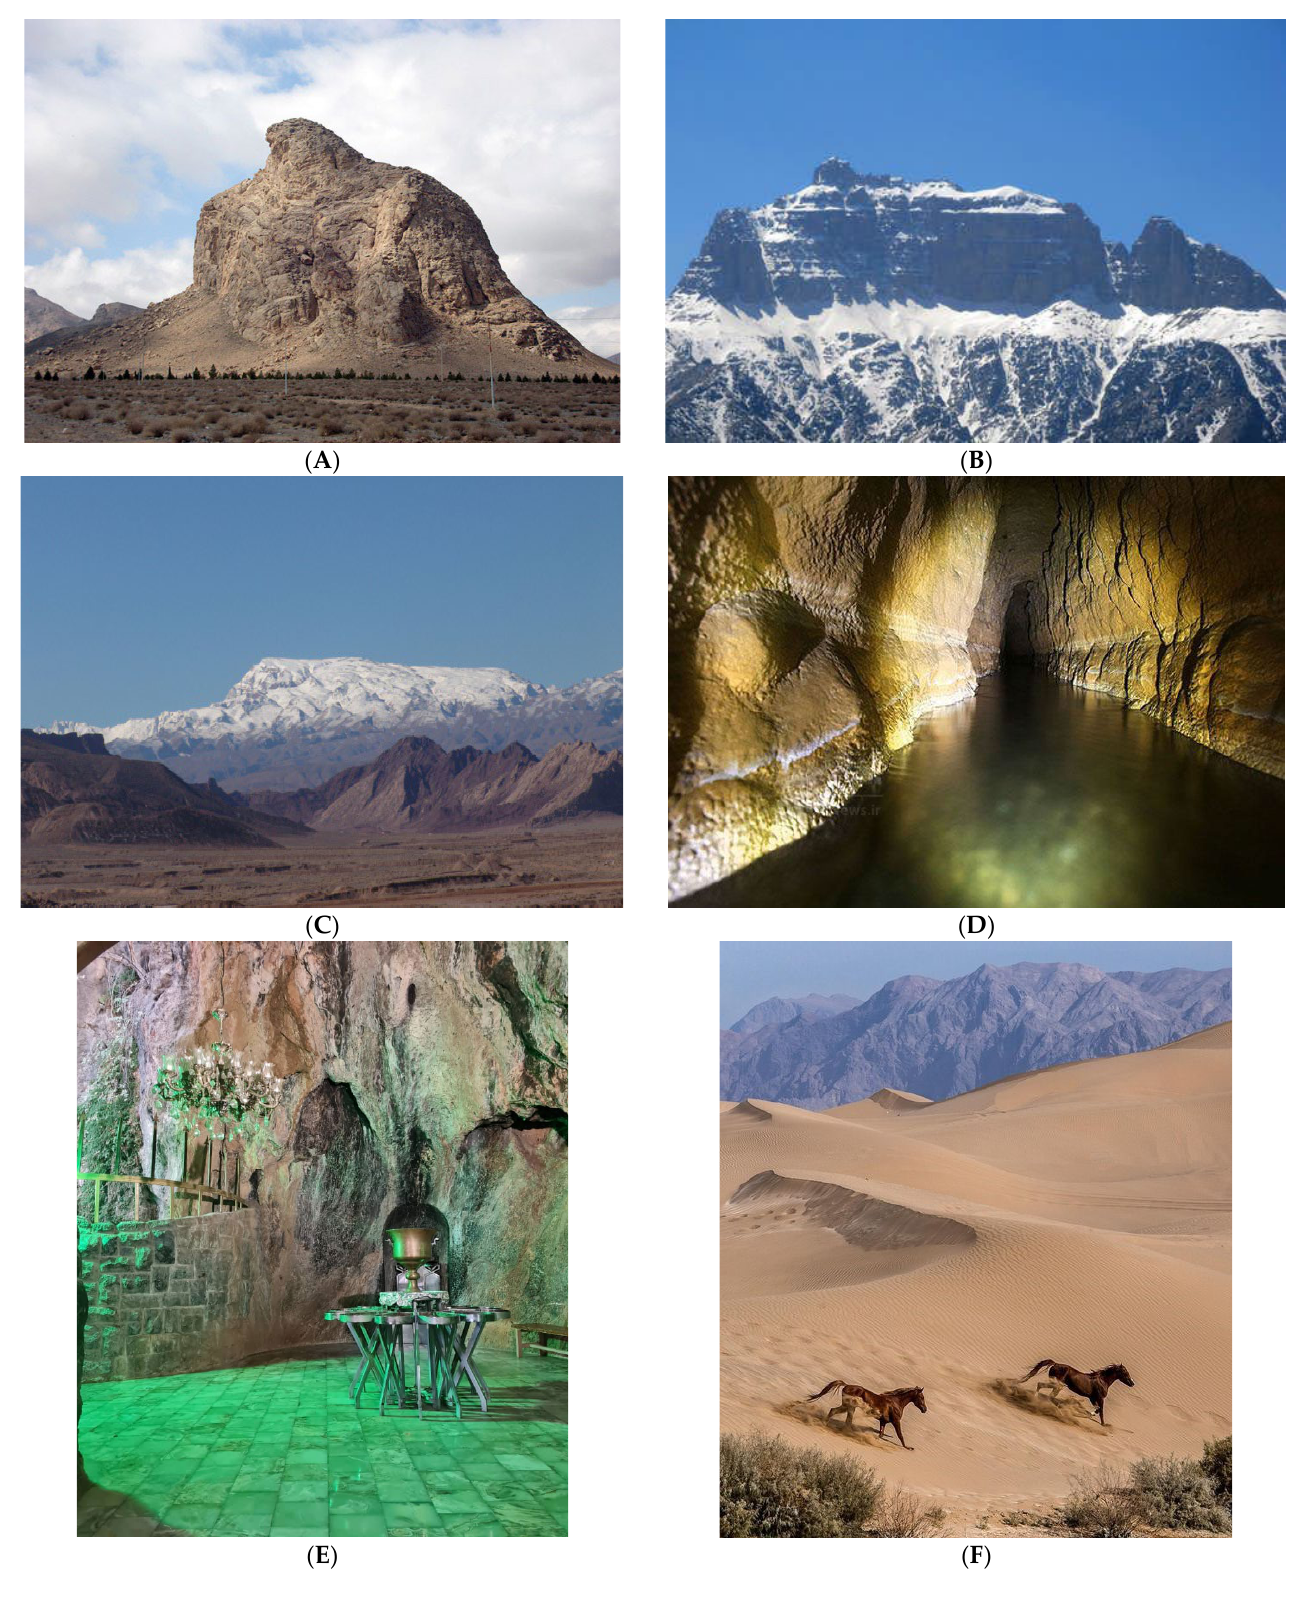
Figure 4. ( A ) The inselberg called “Eagle Mountain”; ( B ) Tejerjan Snow House; ( C ) Shirkooh Heights; ( D ) Aqueduct (Qanat); ( E ) Chak Chak (Photo source: S. Zareh ® ); ( F ) Siahkooh (Black Mountain, Desert, and Protected Area) (Photo source: J. Gorji ®